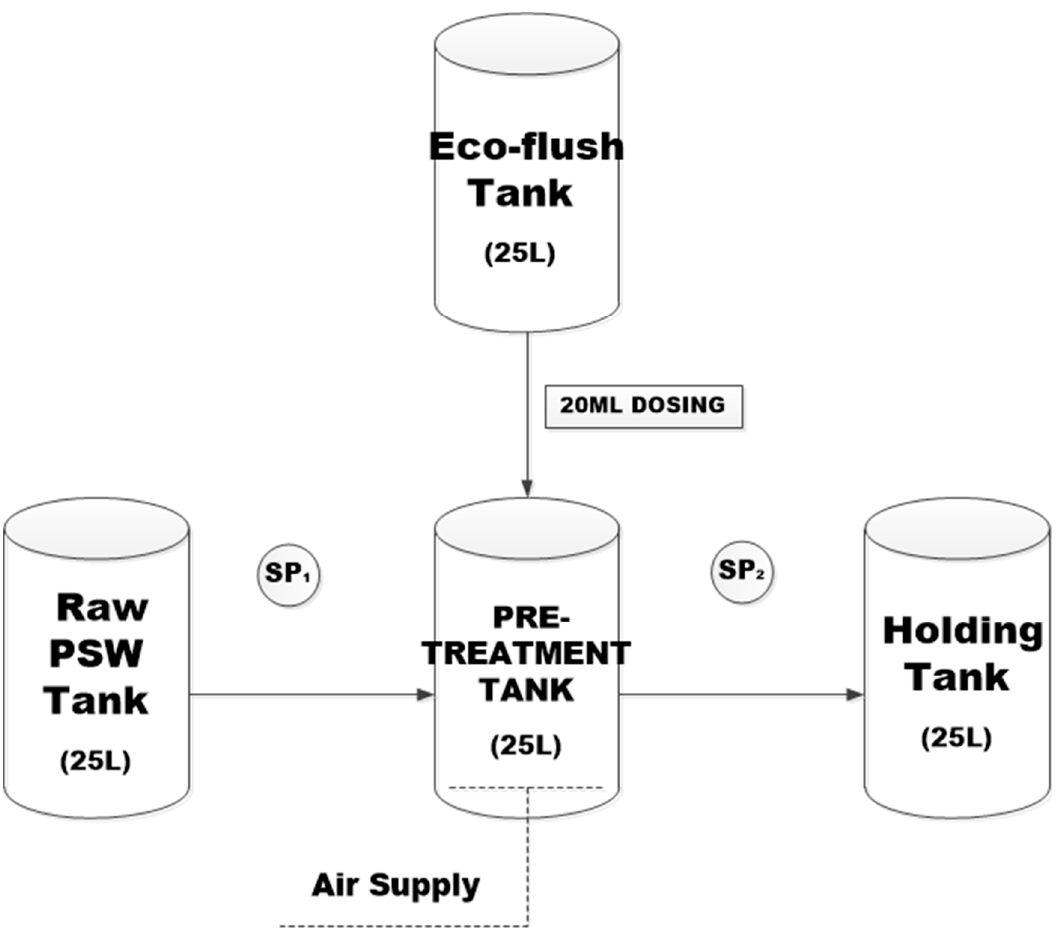
Figure 1. Pre ‐ treatment Process Schematic Diagram. Figure 1. Pre-treatment Process Schematic